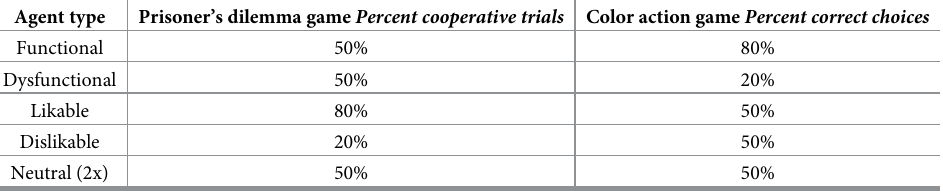
Table 1. Behavioral characteristics per agent in experiment